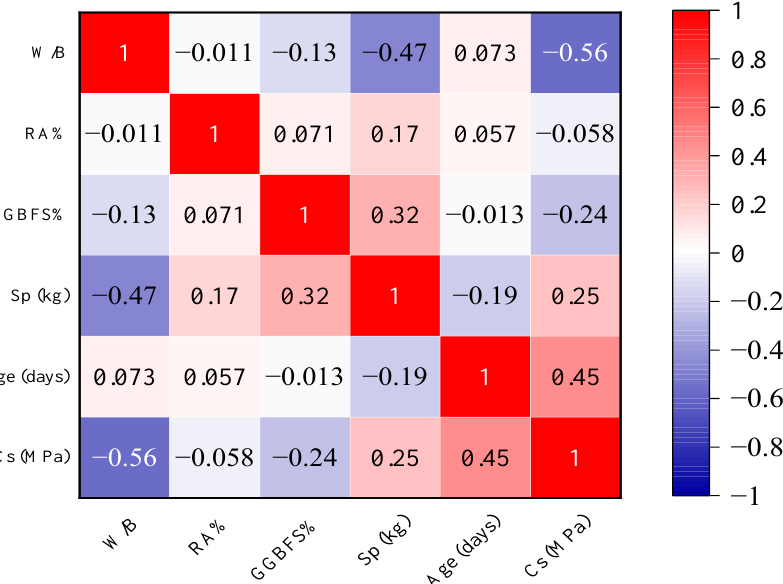
Figure 4. Heatmap showing the correlation between the dataset’s Cs, age, and each eco-friendly concrete component.